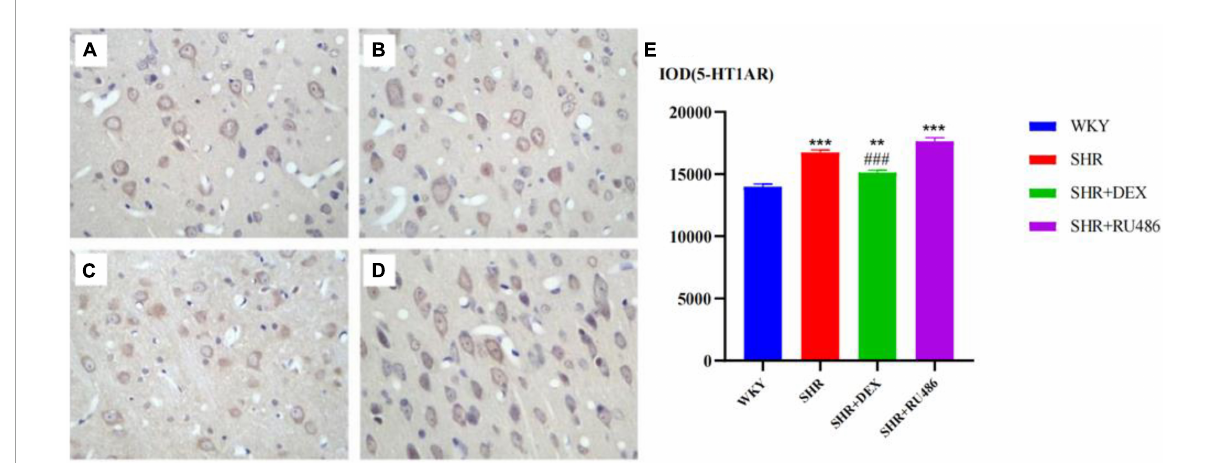
FIGURE6 Comparison of 5-HT1A receptor (5-HT1AR) levels in the prefrontal cortex of rats in four groups ( × 400) [ (A) Wista Kyoto rats (WKY) group; (B) spontaneously hypertensive rats (SHR) group; (C) SHR + dexamethasone (DEX) group; (D) SHR + RU486 group]; Comparison of 5-HT1AR levels in the prefrontal cortex of rats in four groups (E) . One-way analysis of variance (ANOVA) with repeated measures followed by post hoc with Tukey test. All data are presented as mean ± SEM. *** p < 0.001, ** p < 0.01, compared to WKY group; ### p < 0.001, compared to SHR group.